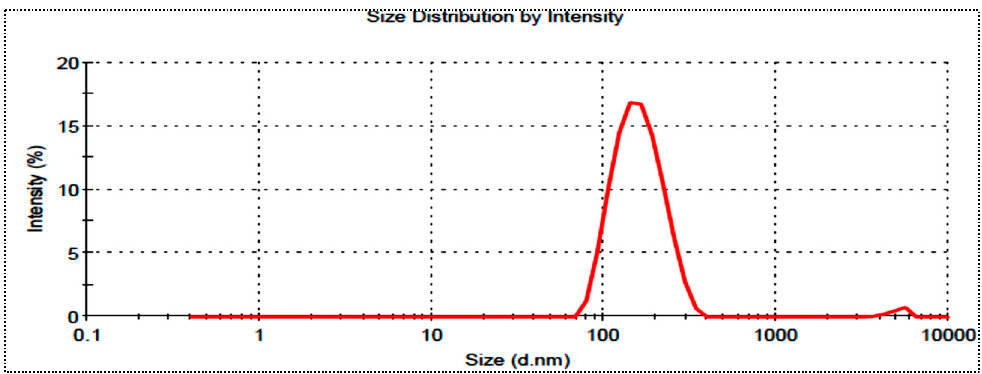
Figure 6. Hydrodynamic diameter image of optimized moxifloxacin bilosomes (MX-BSop).